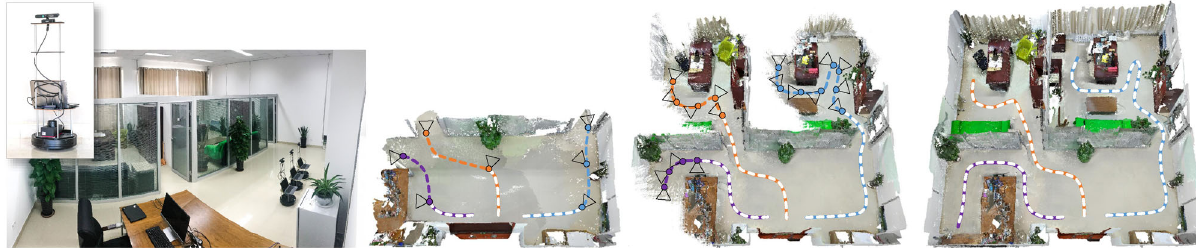
Fig. 12 Multi-robot collaborative scene reconstruction algorithm. Reproduced with permission from Ref. [18], c (cid:2) ACM